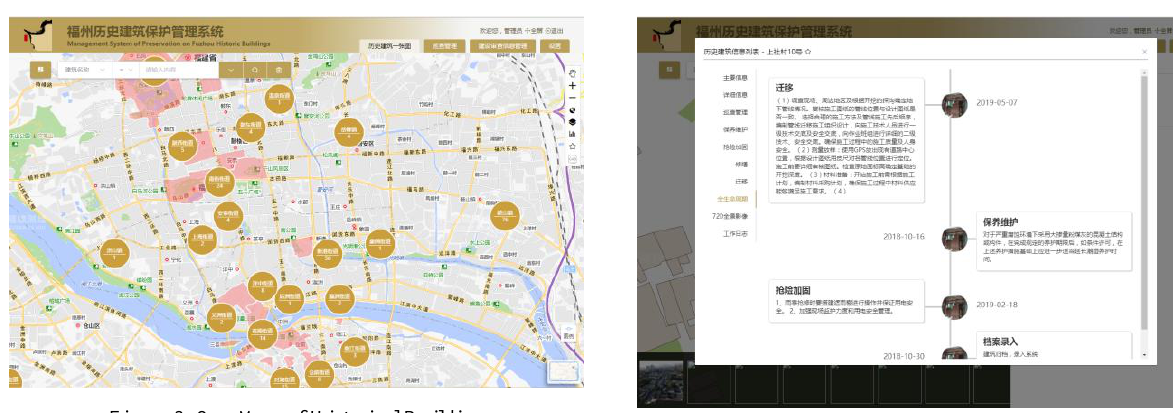
Figure 3. One Map of Historical Building